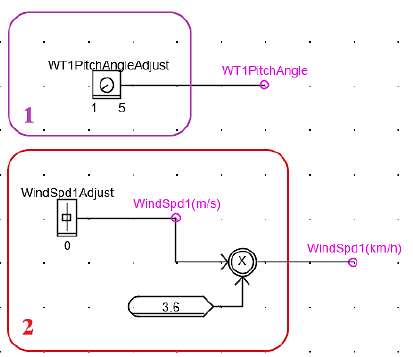
Figure 9. Setting values for the default air temperature, barometric pressure, and relativity.